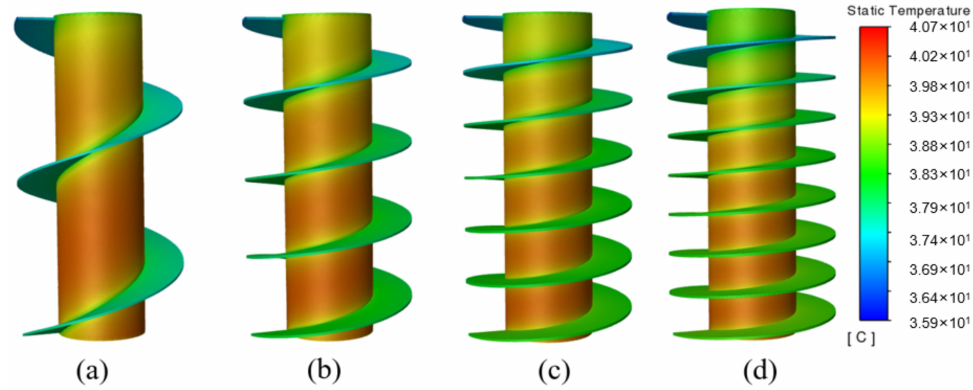
Figure 10. Temperature cloud diagram under different numbers of fin turns: ( a ) 2 T; ( b ) 4 T; ( c ) 6 T; ( d ) 8